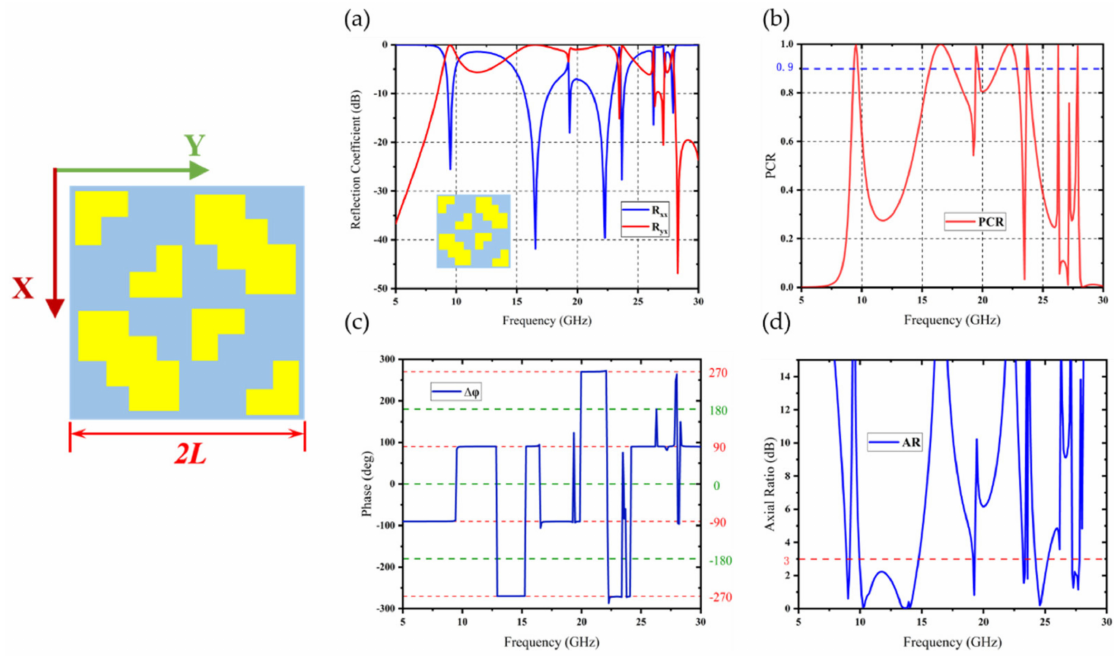
Figure 3. Simulation results of combined unit. ( a ) Reflection coefficient. ( b ) PCR. ( c ) Phase difference. ( d )